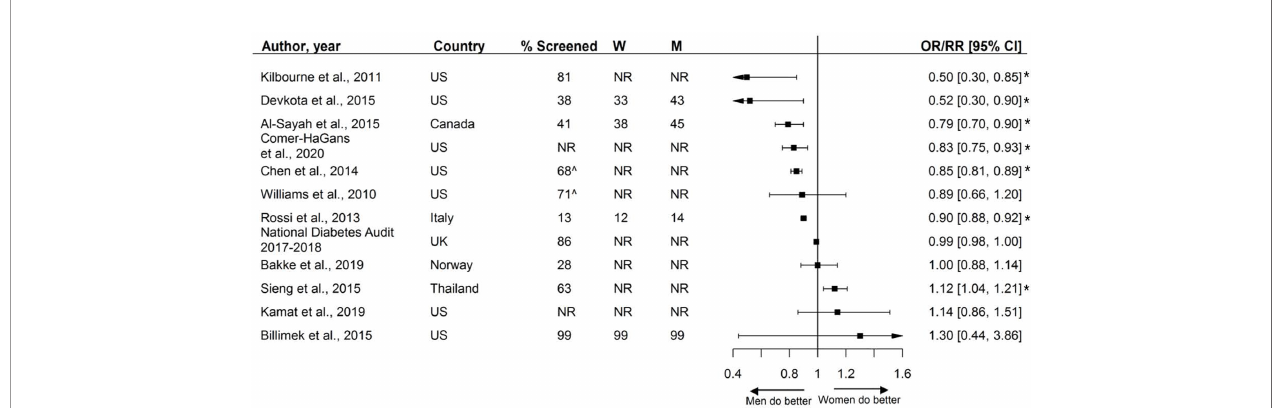
FIGURE 8 | Foot exams, expressed as adjusted odds ratios (OR) with corresponding 95% con fi dence intervals (CI). One study is not presented in this fi gure because of the measure of association: Du et al., (92): Prevalence difference (95% CI 4.2 ( − 6.4; 14.9).W = % of screened women; M = % of screened men; US, United States; UK, United Kingdom; ^ = assumed to be weighted %. % Chen et al. extracted from the last available year. Men = reference. * = statistically signi fi cant.